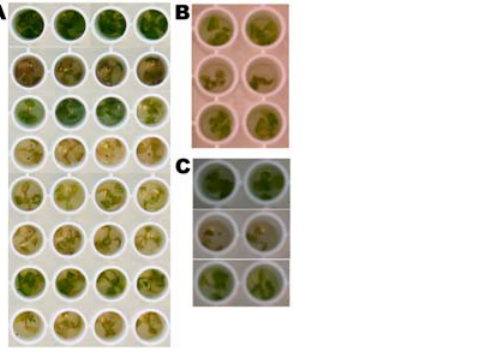
Figure 1. Visual phenotype of seedlings infected with different microbes. Seedlings grown in 96 well plates (one per well) were infected with indicated microbes and symptoms recorded ( A ) 5dpi, ( B ) 3dpi and ( C ) 4dpi. ( A ) the different rows display seedlings 1. untreated, or treated with 2. P. aeruginosa -PA14, 3. PA14:: lasR , 4. B. subtilis , 5. E. coli (Dh5a), 6. DC3000, 7. DC3000:: hrcC , 8. DC3000(pAvrB). ( B ) rows: top- untreated control, middle- E.coli , 3. bottom- E.coli expressing GFP in a plasmid. ( C ) rows: top-untreated control, middle- B. subtilis , bottom-